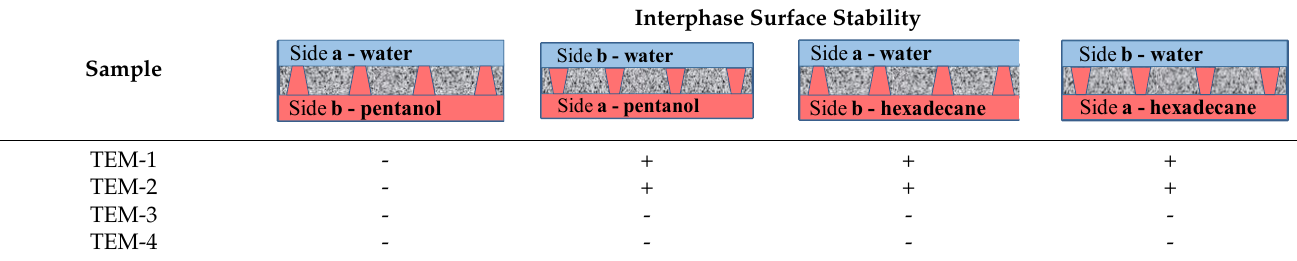
Table 4. Influence of the arrangement of the sides of the track-etched membranes.